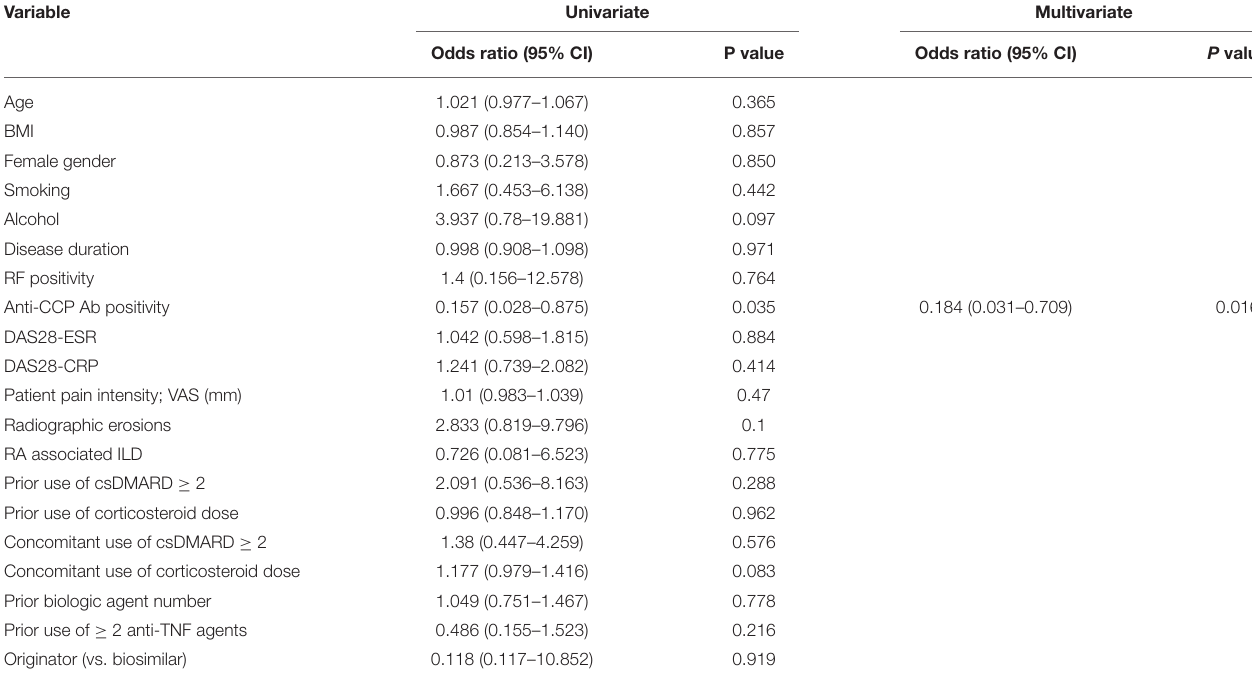
TABLE 5 | Binary logistic regression analysis of risk factors associated with treatment failure in patients with RA after treatment with